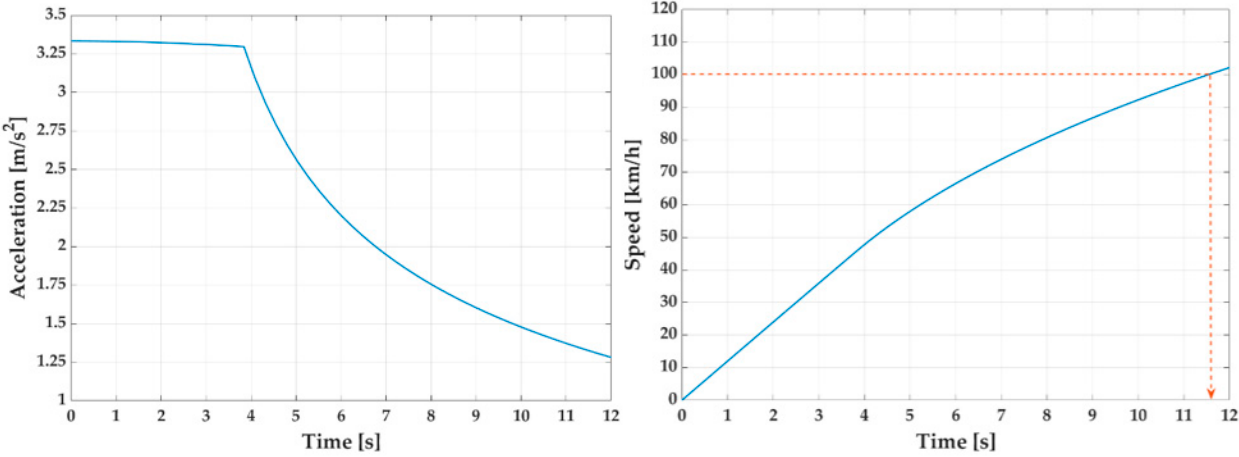
Figure 4. Vehicle acceleration vs. time and vehicle speed vs. time for acceleration from 0 to 100 km/h.